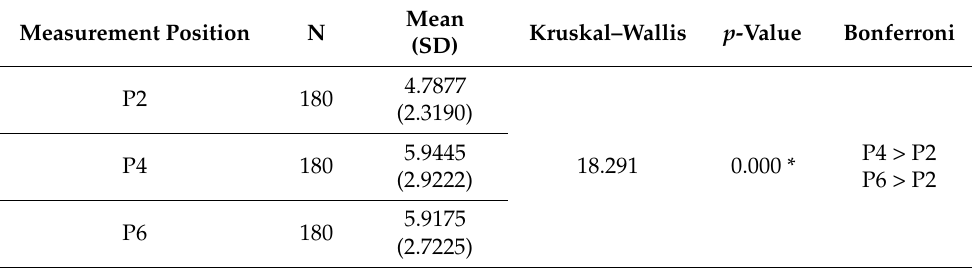
Table 4. Efficiency evaluation of cardiac activity signals according to the measurement